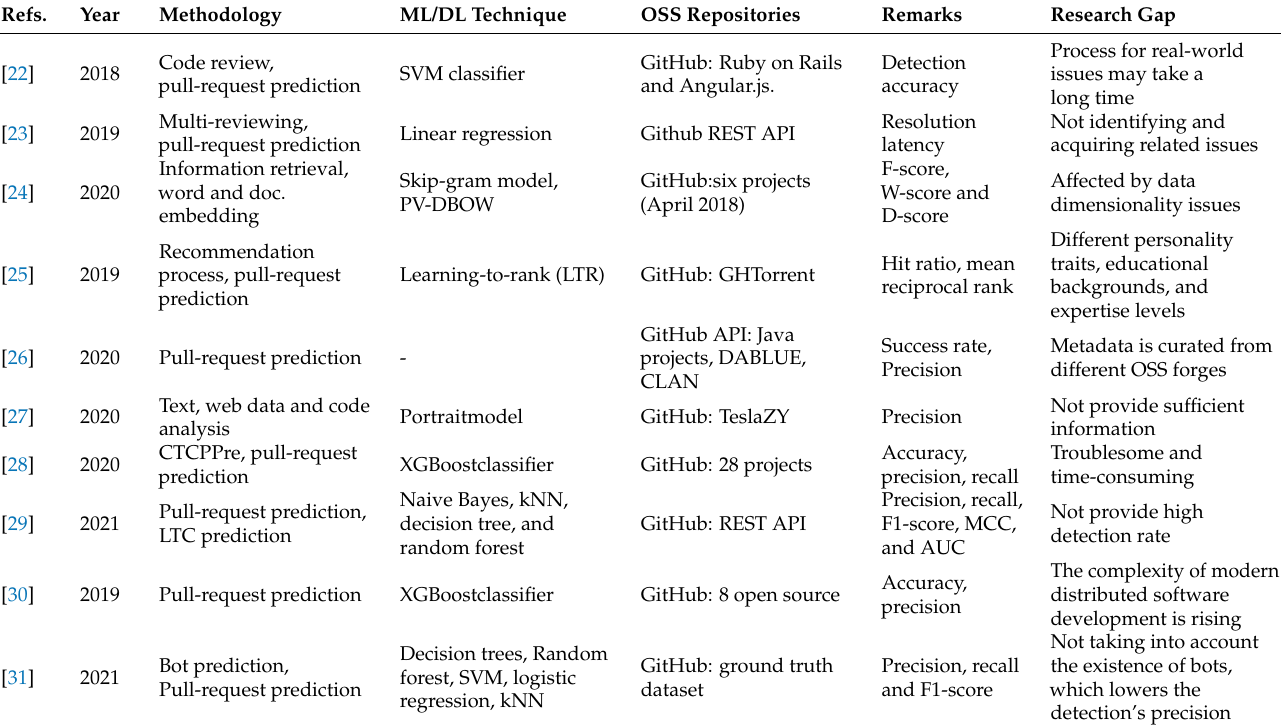
Table 1. Summary of research